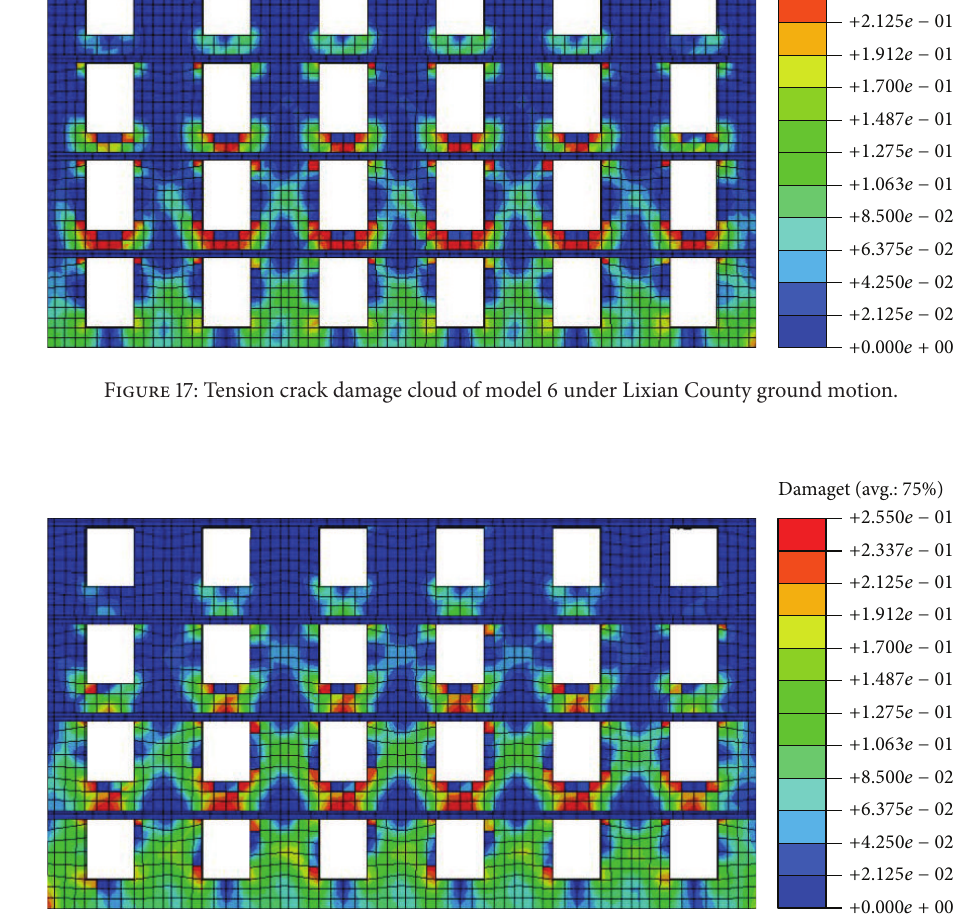
Figure 18: Tension crack damage cloud of model 2 under Lixian County ground motion.